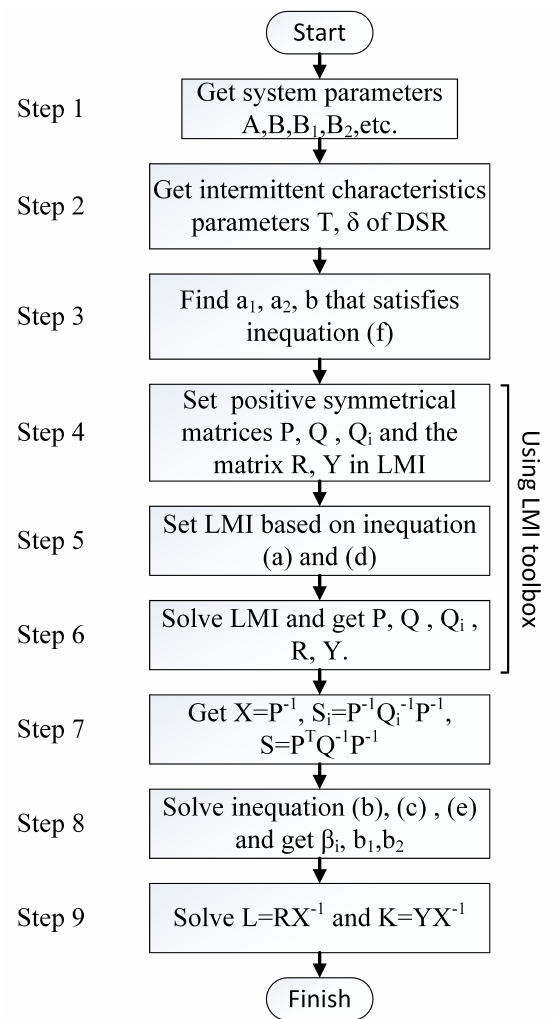
Figure 5. The detailed solution process use LMI toolbox.